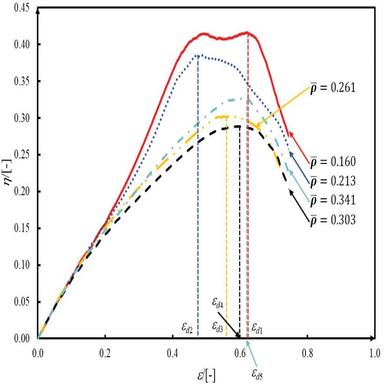
Energy absorption efficiency vs. strain curves of CLL materials with various relative densities.